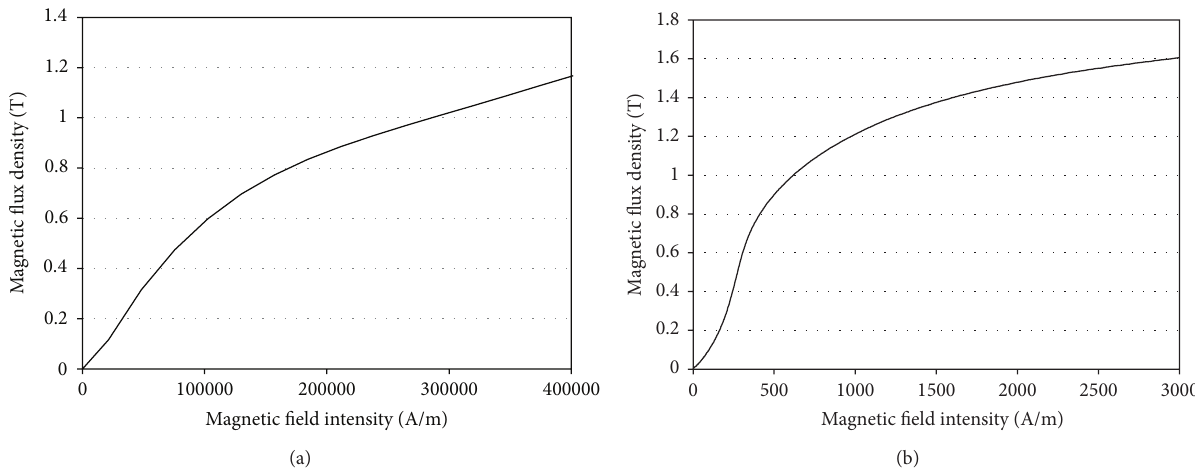
Figure 4: B-H curves of MR fluid and ferromagnetic materials. (a) MR Fluid (MRF-140CG). (b) Ferromagnetic material (SS-400). [13, 33]. The coil turns used to generate electric